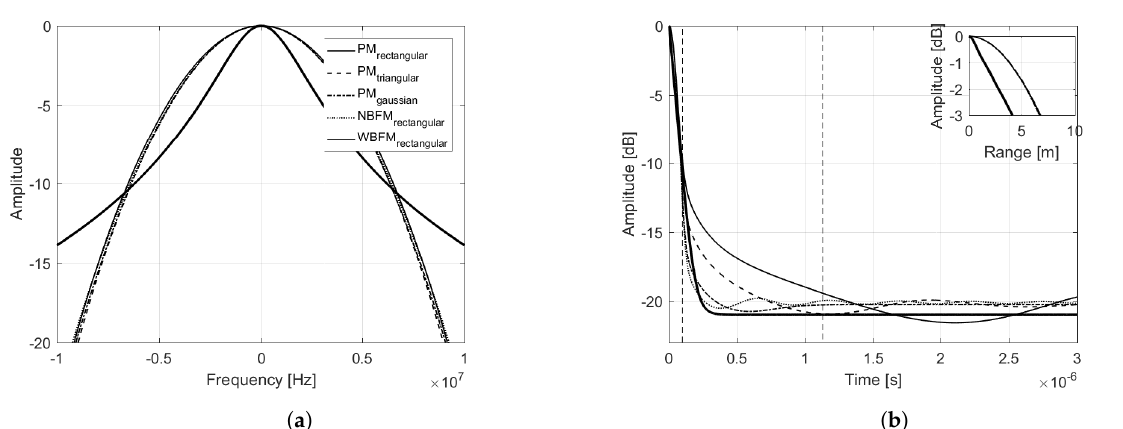
Figure 4. ( a ) Power spectral density and ( b ) Matched filter output power of different transmit signals obtained varying the modulating signal’s properties and the modulation